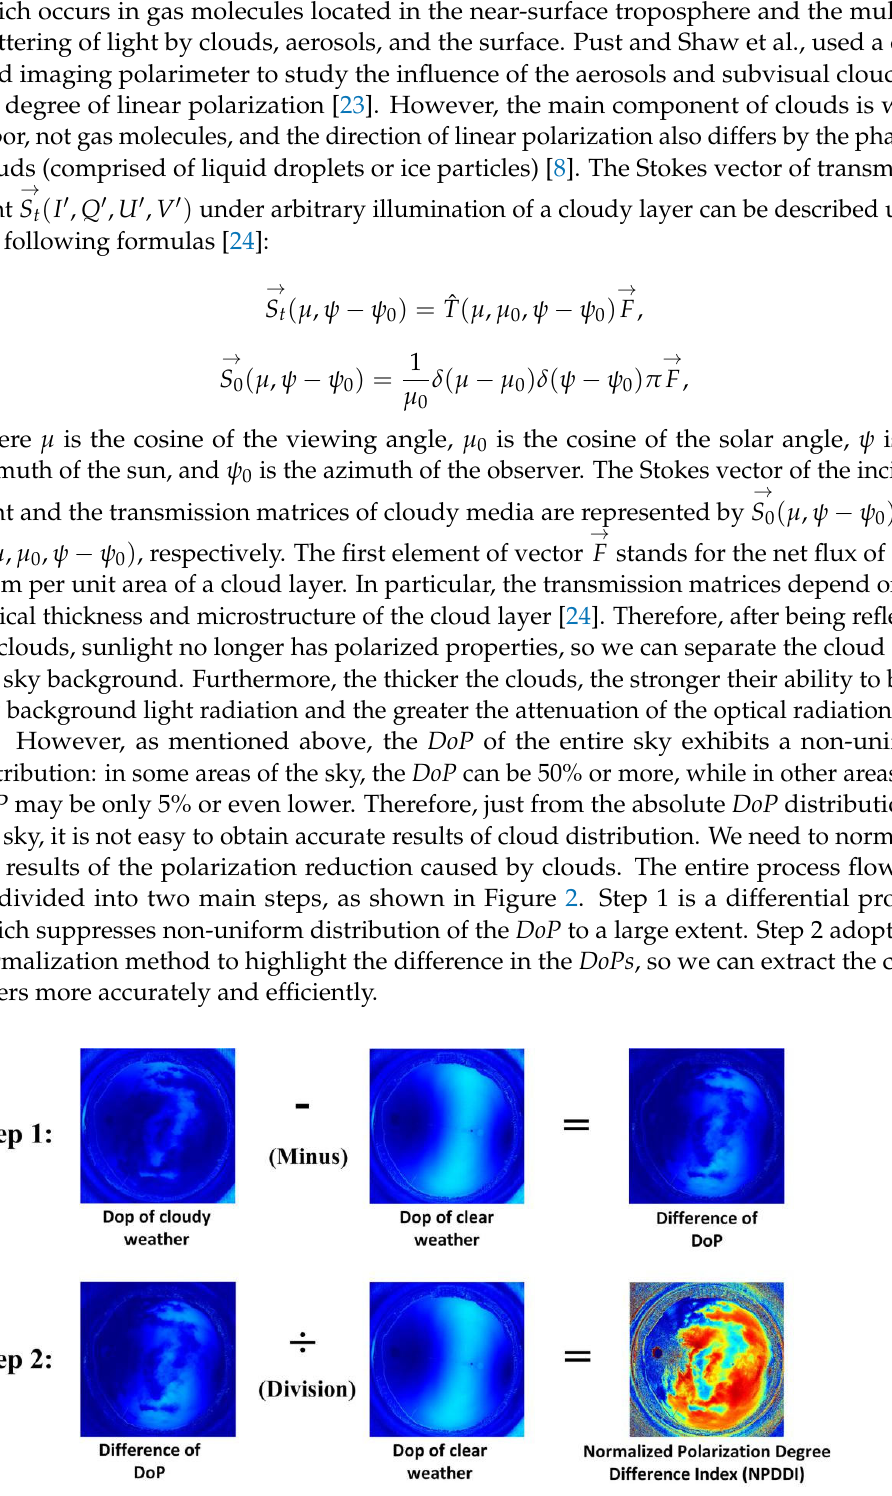
Figure 2. Flow chart of the cloud volume detection algorithm based on skylight DoP distribution. The final output of the algorithm is the NPDDI distribution result. The value range of the result is [0, 1], and the larger the value, the thicker the clouds.